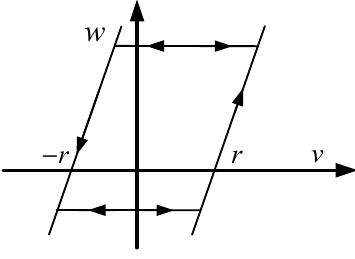
Figure 14. Structure of the proposed Prandtl ‐ Ishlinskii model. The procedure of PSO is as follows: I. Initialization of particle swarms: 100 particles with a dimension of 20, including the number of particle swarms, random position, and speed of particles, are initialized. II. Calculation of fitness of each particle: